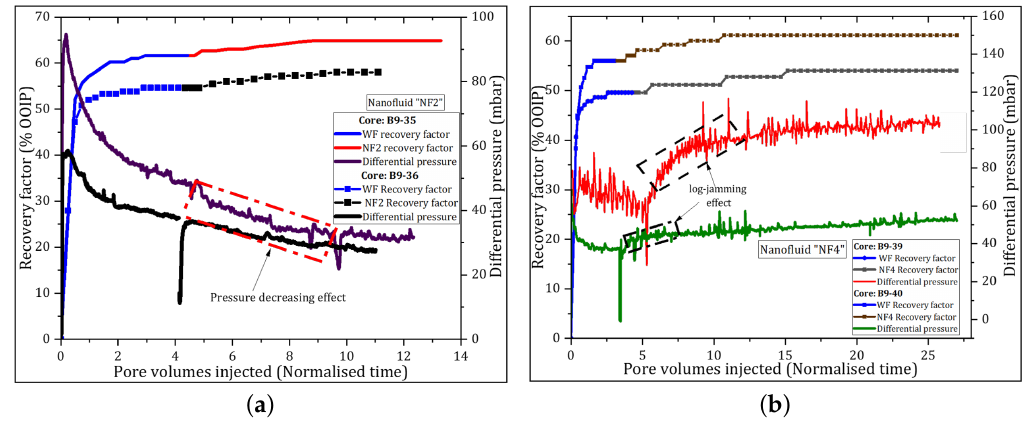
Figure 5. Tertiary oil recovery factors and dP versus PV recorded during the nanofluid flooding. Two parallel tests were conducted for each nanofluid type: ( a ) NF2; and ( b ) NF4.